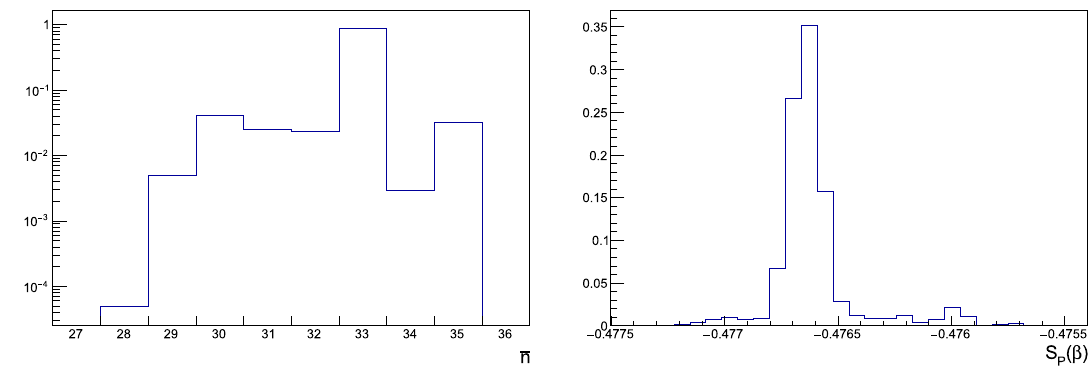
Fig. 13 Normalised distributions, over 10 5 bootstrap samples, of ¯ n (left panel) and S P (β) (right panel) for L = 48, β = 5 . 3